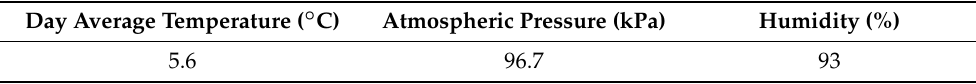
Figure 3. Time history of the voltage across the